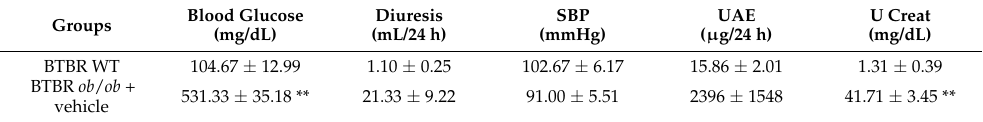
Values are expressed as mean ± SD. ** p < 0.01 vs. BTBR WT; n = 3 animals for each group. Abbreviations: SBP, systolic blood pressure; UAE, urinary albumin excretion; U Creat, urinary creatinine.